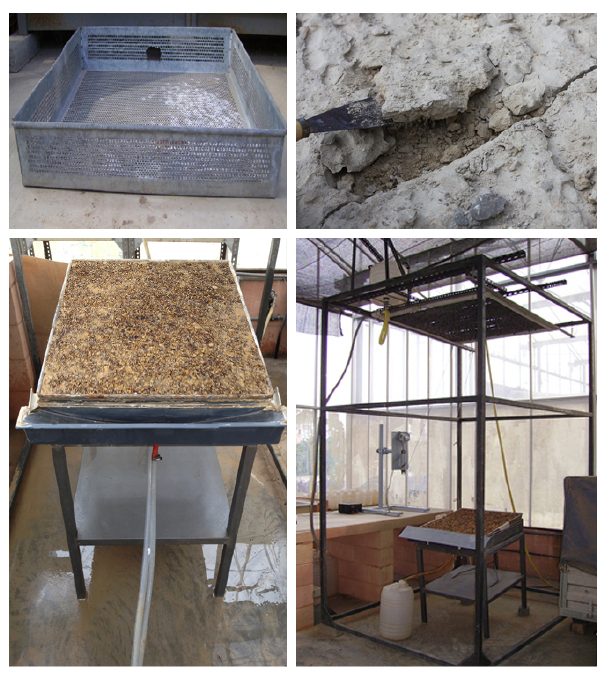
Figure 1. Experimental equipment and crust